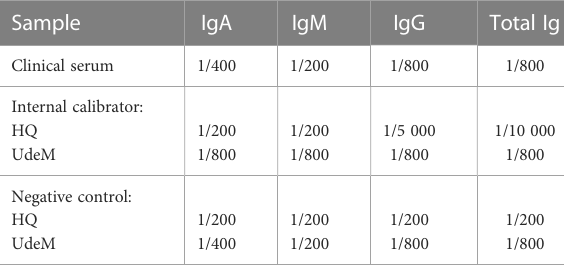
TABLE 1 Serum dilutions used in ELISA a .